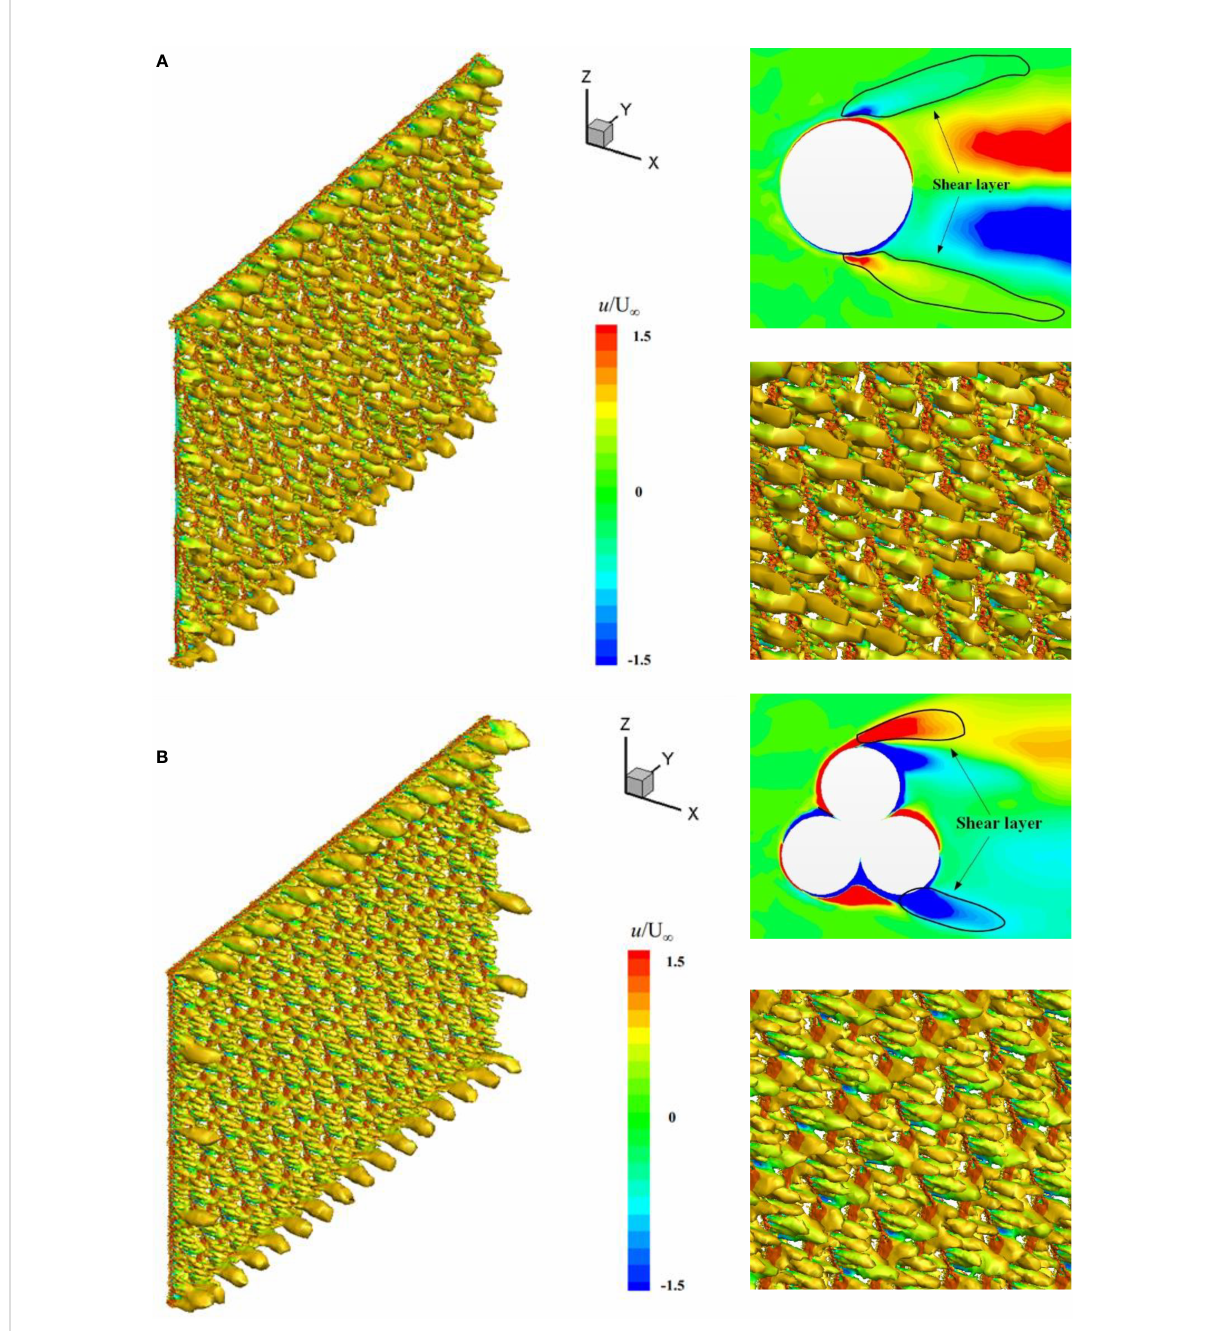
FIGURE 8 Instantaneous vortex structures and detailed shear layers of the individual twines at Re = 4500. (A) Equivalent-twine net and (B) twisted- twine